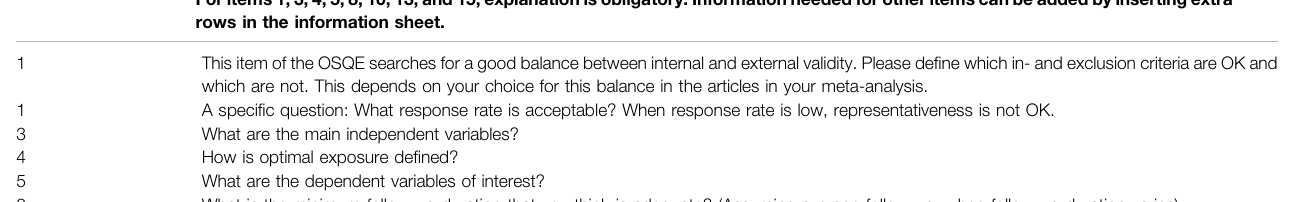
TABLE 1 | Information sheet; several questions to be answered before scoring the OSQE cohort. Information sheet Raters performing a systematic review or meta-analysis: Please answer the questions below before scoring the OSQE. File the marked articles. Answer the questions for your review, not for each article separately. For example, your main dependent variable can be a secondary outcome in the article, but still, you have to score the validity of that outcome. Cave: Numbers correspond with the numbers in the